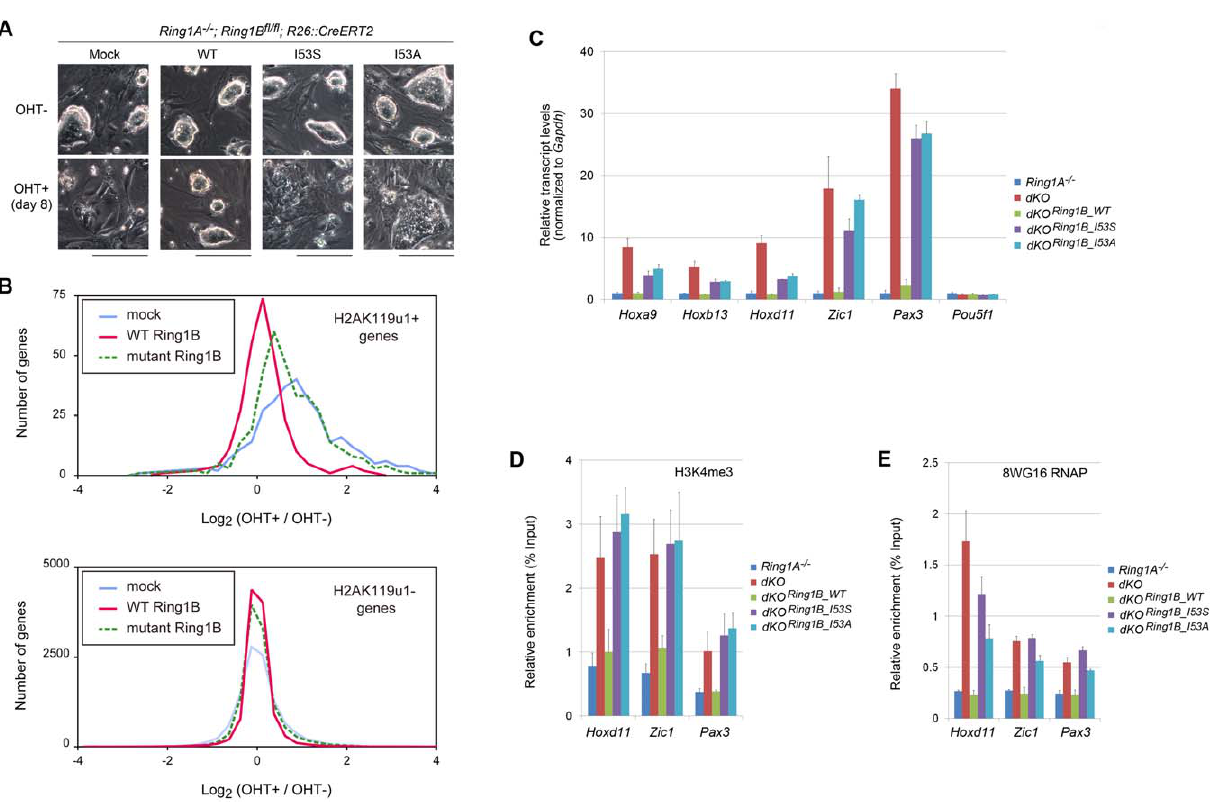
Figure 3. H2A ubiquitination activity of Ring1B is essential for the maintenance of ESC identity and repression of target gene expression. (A) Morphology of OHT-untreated and –treated (day 8) Ring1A 2 / 2 ; Ring1B fl/fl ; R26::CreERT2 ESC lines expressing the indicated transgene. The images were acquired under a phase-contrast microscope. Scale bars indicate 200 m m. (B) Histograms showing the expression changes of H2AK119u1 + and H2AK119u1 2 genes in Ring1A 2 / 2 ; Ring1B fl/fl ; Rosa26::CreERT2 ESCs expressing mock (blue line), WT Ring1B (red line), or mutant Ring1B (green dotted line) following OHT treatment. (C) Expression levels of Hoxa9 , Hoxb13 , Hoxd11 , Zic1 , Pax3 and Pou5f1 in Ring1A 2 / 2 ; Ring1B fl/fl ; Rosa26::CreERT2 ESCs expressing mock, WT, I53S, or I53A Ring1B before ( 2 ) or after ( + ) OHT treatment (day 2). Expression levels were normalized to a Gapdh control and are depicted as fold changes relative to mock (OHT-untreated) ESCs. Error bars represent standard deviation determined from at least three independent experiments. (D) Local levels of trimethylated H3K4 (H3K4me3) at promoter regions of representative target genes in Ring1A 2 / 2 ; Ring1B fl/fl ; R26::CreERT2 ESCs stably expressing mock, WT, I53S, or I53A Ring1B before ( 2 ) or after ( + ) OHT treatment (day 2) were determined by ChIP and site-specific real-time PCR. The relative amount of immunoprecipitated DNA is depicted as a percentage of input DNA. Error bars represent standard deviation determined from at least three independent experiments. (E) As in (D), but showing local levels of RNA polymerase II (RNAP) detected with the 8WG16